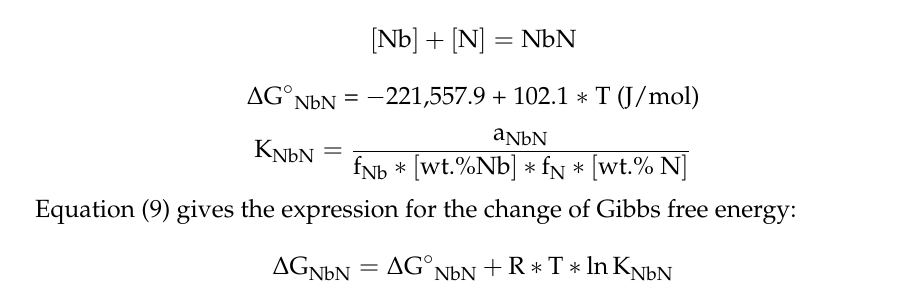
Table 6. Second-order cross-interaction parameter r i,j